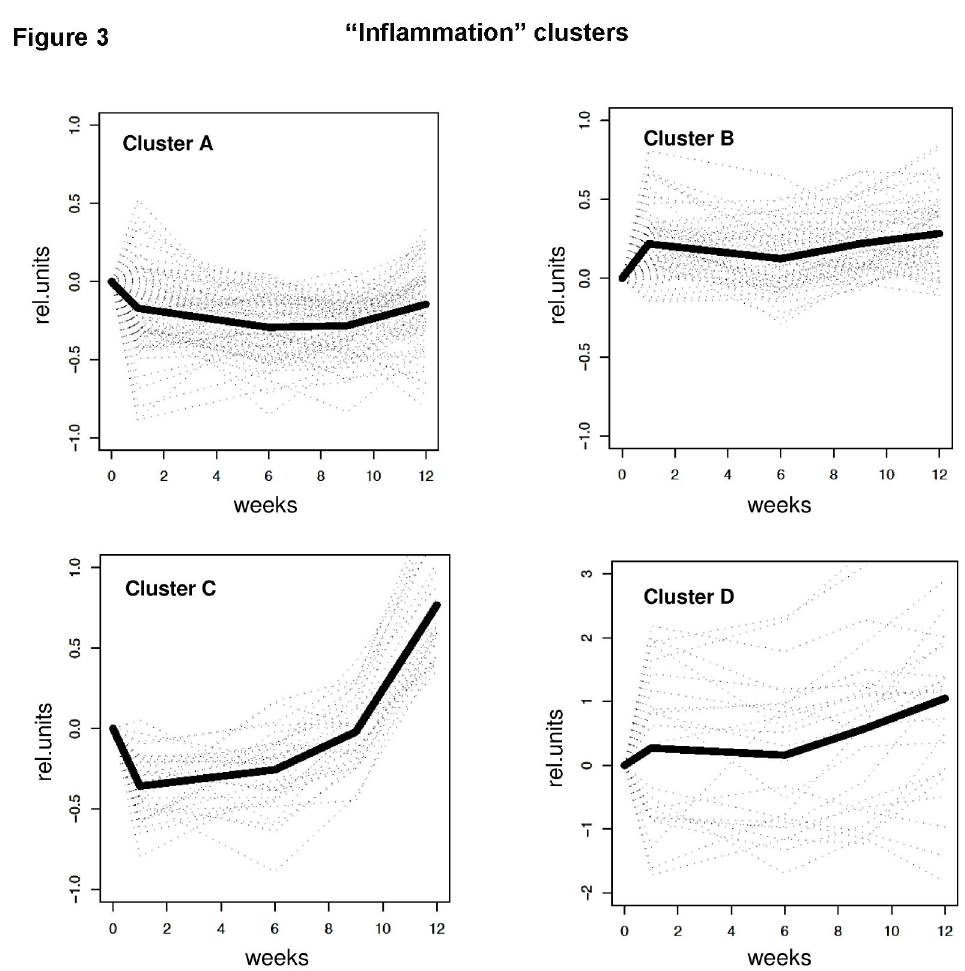
Figure 3. Cluster analysis of inflammatory genes. Bayesian cluster analysis of genes with ‘inflammation’ gene ontology resulted in 4 clusters A, B, C and D with distinct time profiles. Individual gene expression profiles are shown as dotted lines. The bold line represents the cluster